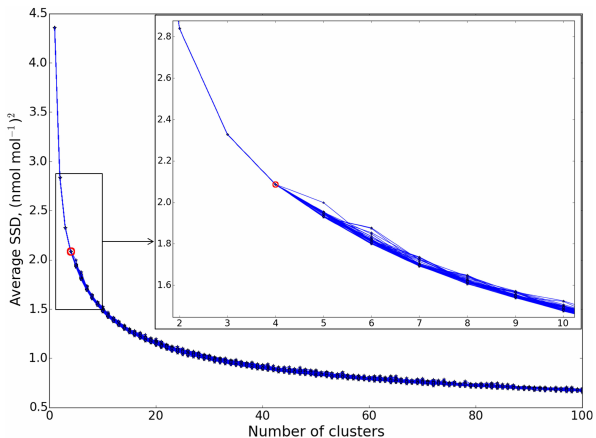
Figure 2. Averaged SSD (“elbow” plot) of 50 · 100 independent k - means runs with varying number of clusters k from 1 to 100, based on the second set of properties.